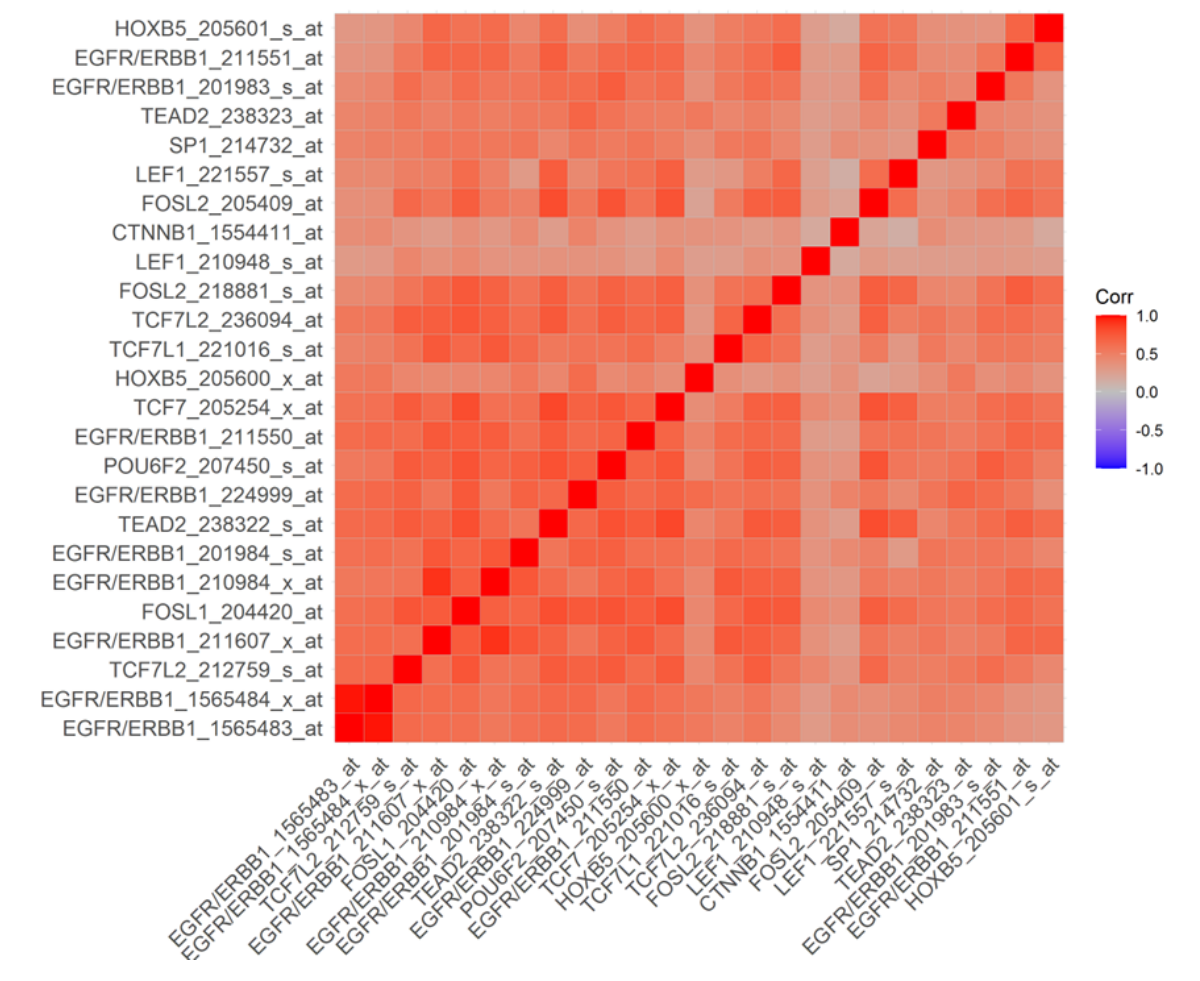
Figure 4. Correlation matrix of EGFR/ERBB1 probesets and transcription factors with the most sig- nificant positive correlations in MM